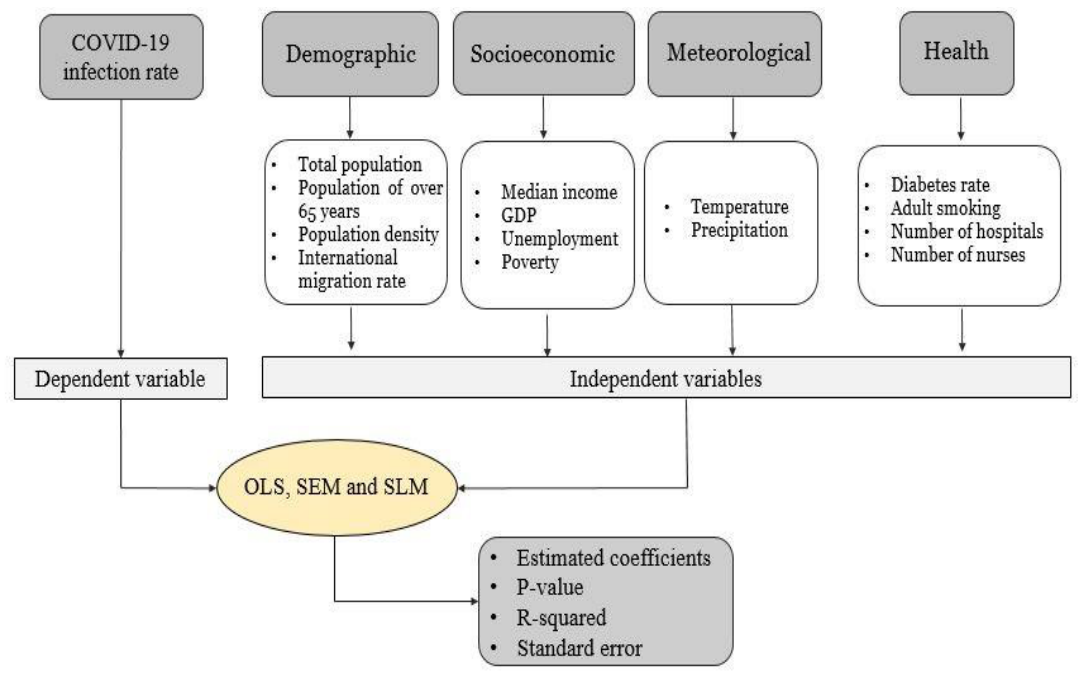
Figure 2. The general workflow for this